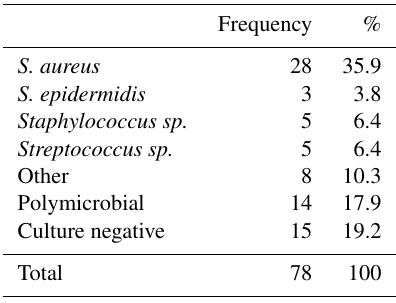
Table 2. Causative